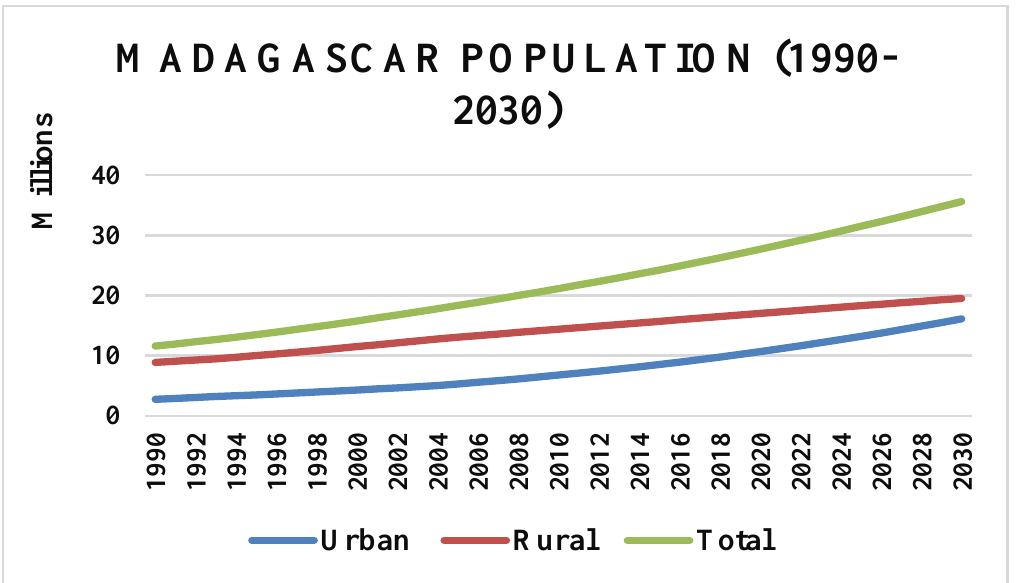
Figure 5. Madagascar population from 1990 to 2030. Data source: UN DESA Population Division World Population Prospects (2019) and World Urbanization Prospects (2018)